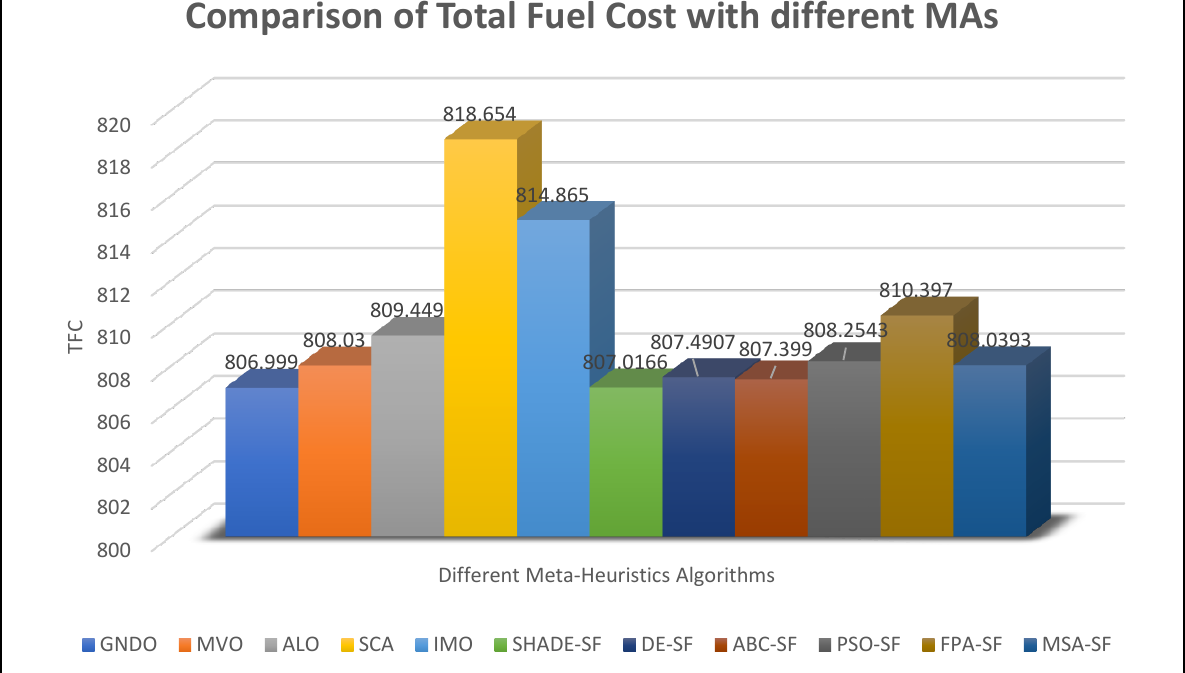
Figure 18. Comparison chart for TFC minimization with different algorithms.